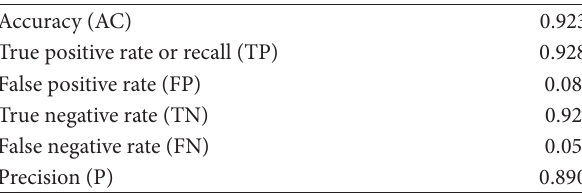
Table 6: Performance of nipple detection classifier.